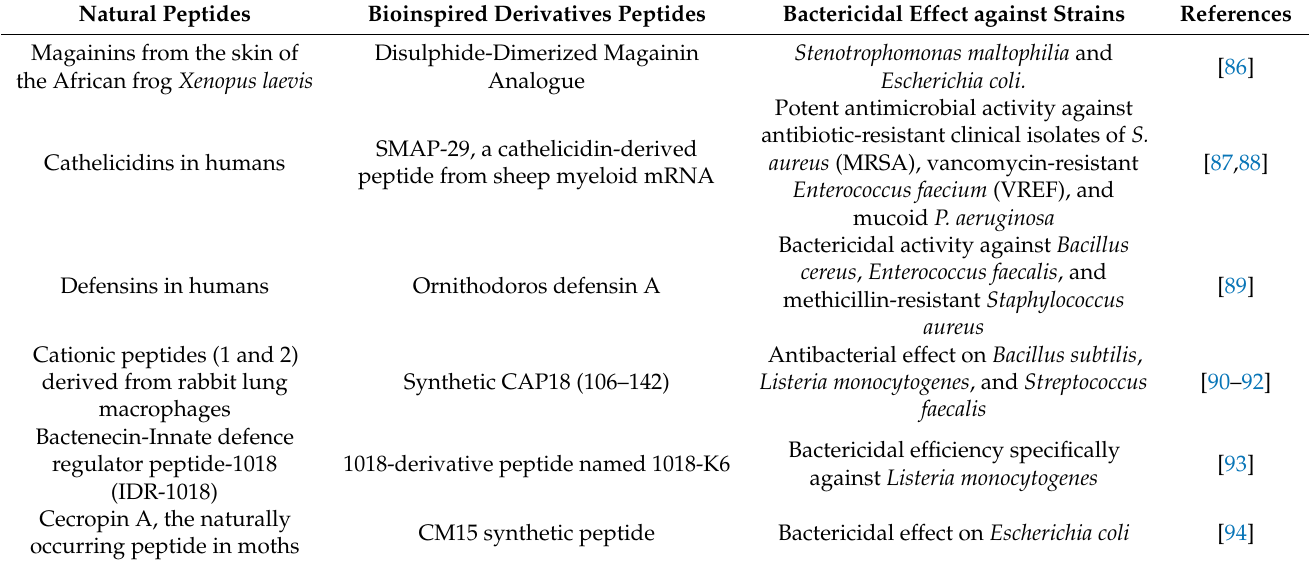
Table 4. Bioinspired peptides against foodborne